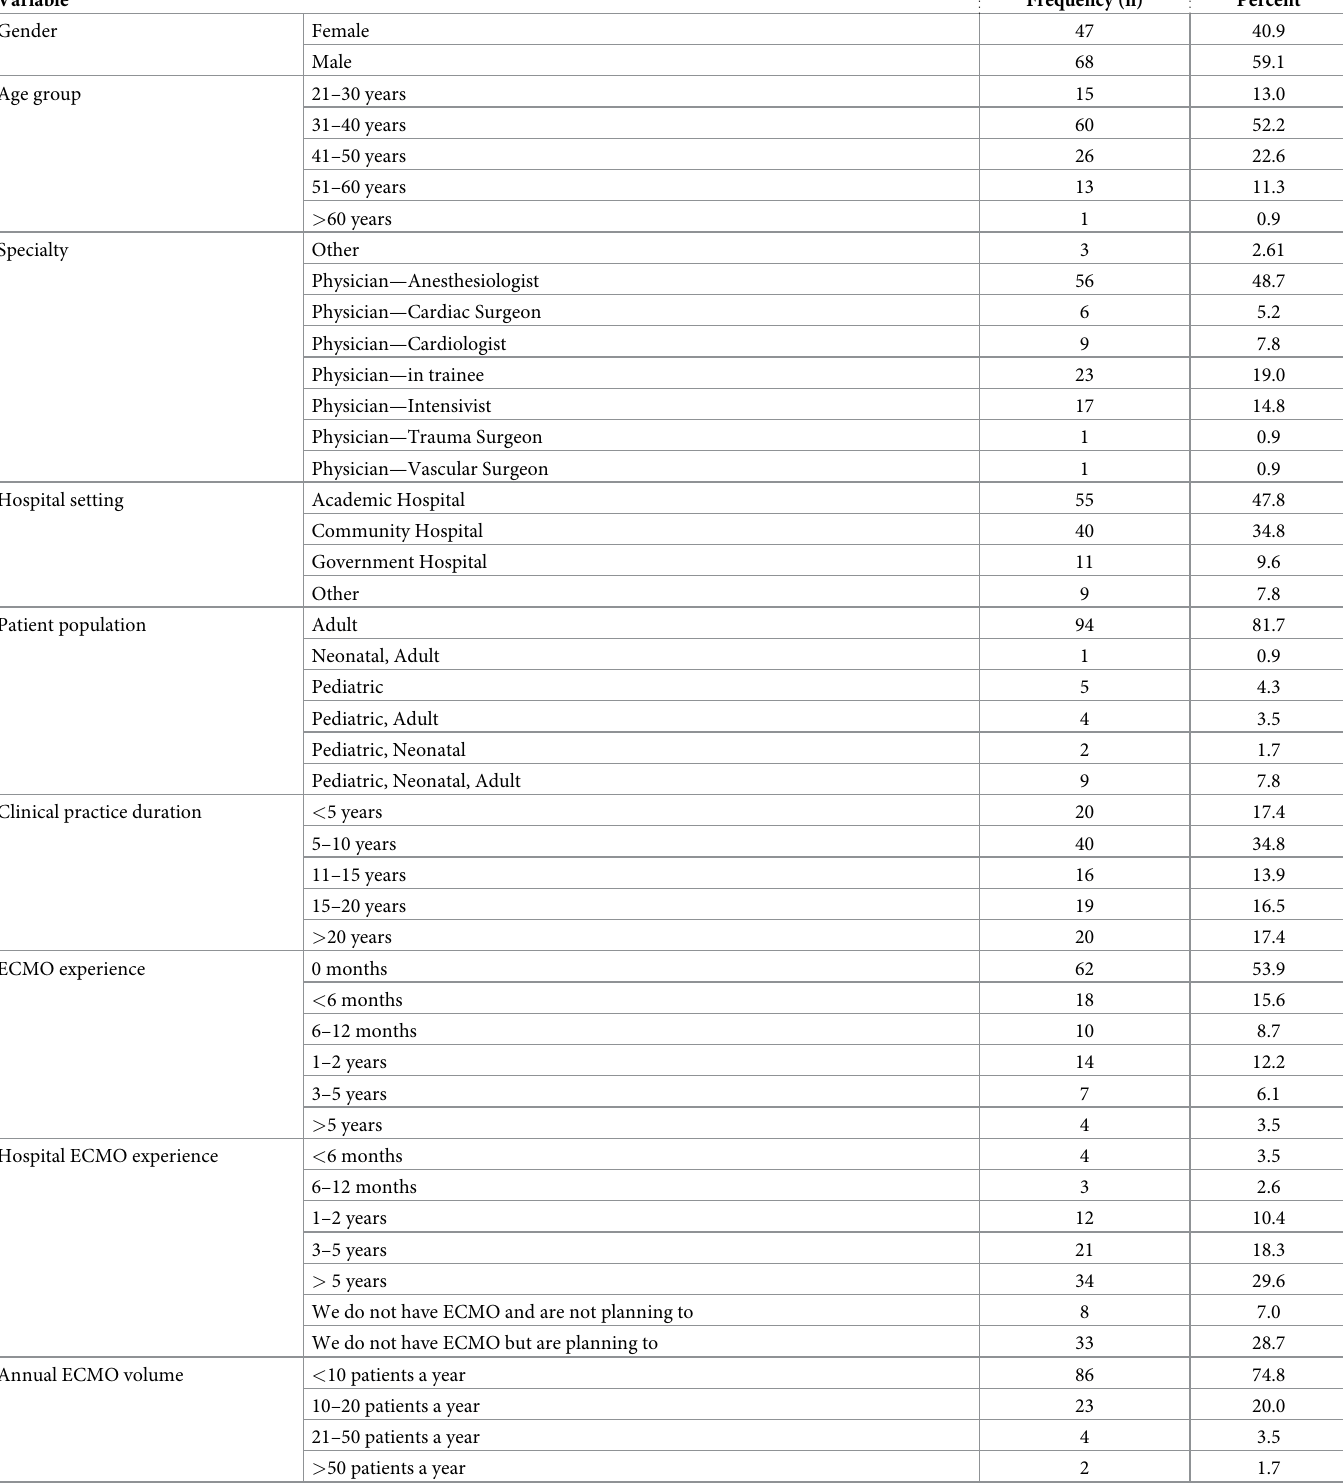
Table 2. Participant demographics, specialty and hospital settings with clinical practice and ECMO